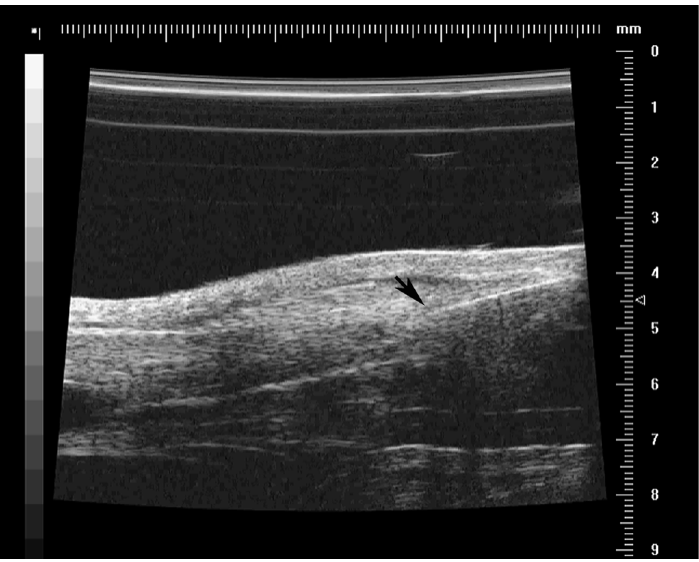
Fig 1. Ultrasound (US)-guided intratendinous injection. The needle (arrow) is clearly visualized with US guidance. The image of the tendon tissue expansion confirms the effect of the high-volume intratendinous